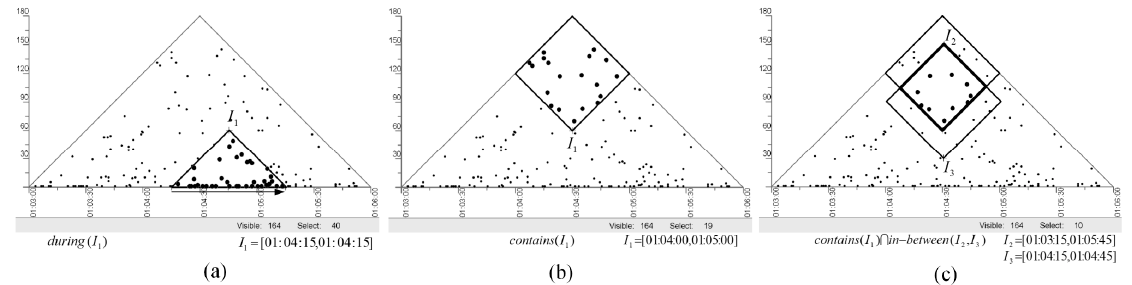
Figure 4. Temporal queries in the TM by creating 2D zones. ( a ) Selecting intervals during I 1 . ( b ) Selecting intervals contained by I 1 . ( c ) Selecting intervals containing I 1 and in-between ( I 2 , I 3 ) (adapted from [14]) .